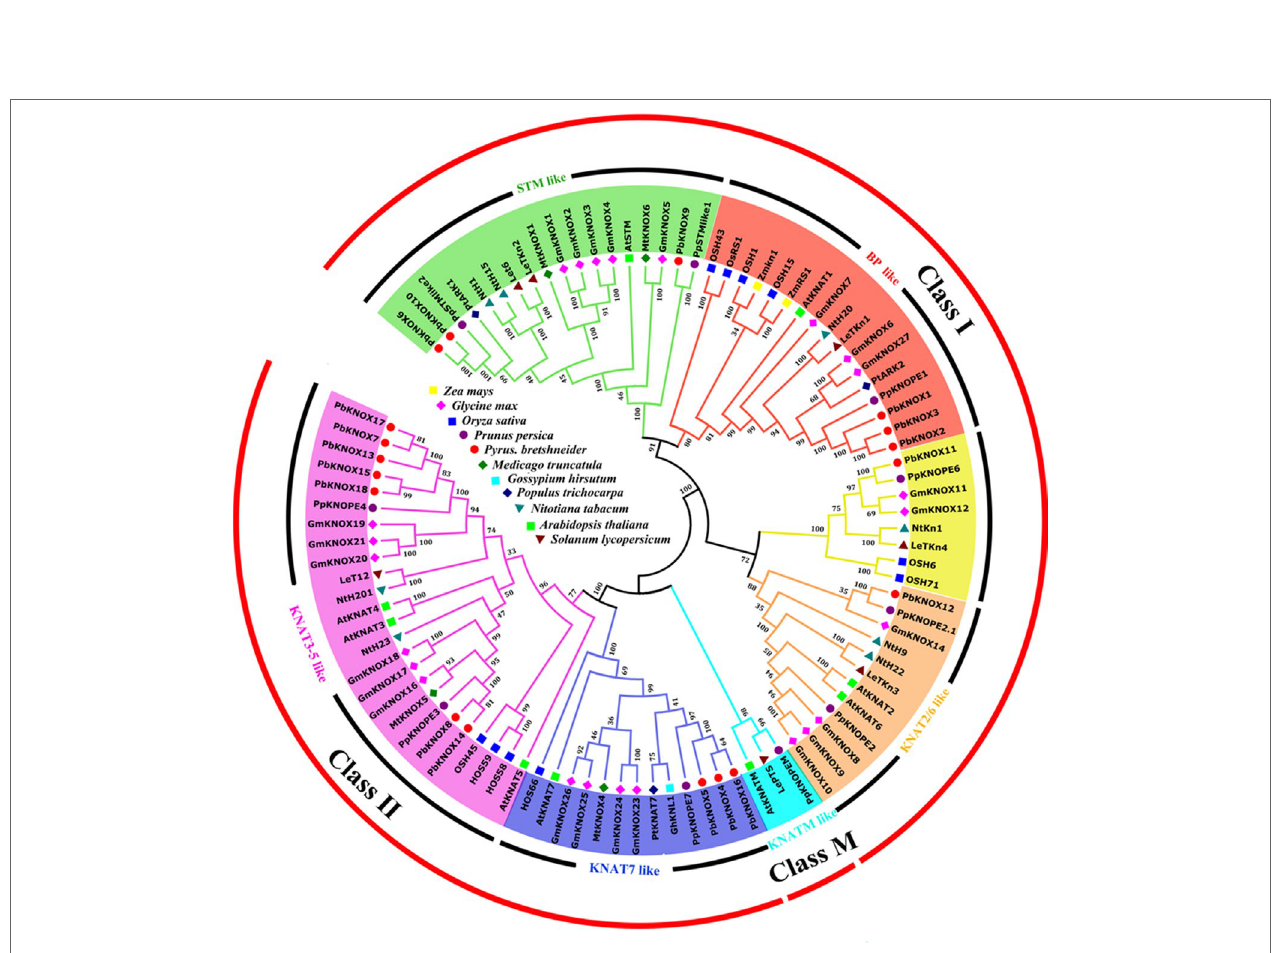
FIGURE 5 | Interspecific phylogenetic tree of KNOX protein sequences from various species. Bootstrap values (at the branching points) are given for major nodes and are based on 1,000 replicates. Names of the species and the GenBank accession numbers of the sequences used in this tree are listed in Table S1